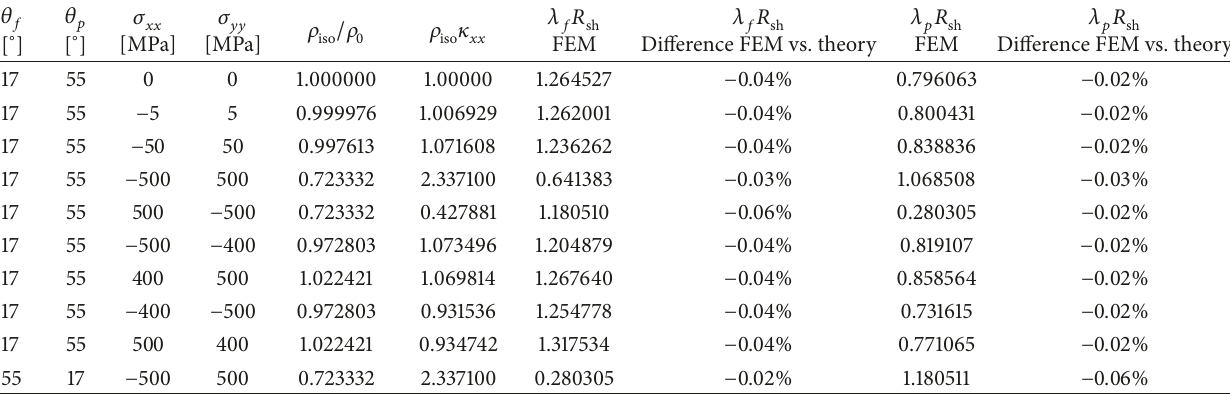
Table 2: Mechanical stress sensitivity of a circular device from Figure 10(a): comparison of numerical finite element simulation (FEM) versus analytical theory. 𝜆 𝑓 𝑅 sh is the resistance between the 𝜃 𝑓 -contacts in Figure 10(a) and 𝜆 𝑝 𝑅 sh is the resistance between the 𝜃 𝑝 -contacts in Figure 10(a). The mesh of the FEM-simulation had 2.66 million elements and the model used Lagrange multiplier and the piezoresistivity matrix from (6a) to (6c) with 𝜋 11 = 6.6 × 10 −11 / Pa, 𝜋 12 = −1.1 × 10 −11 / Pa, and 𝜋 44 = 138.1 × 10 −11 / Pa. The theory used (18d), (18e), (18g), (18h), (18i), (28b), (28c), and (26b) for 𝜌 iso 𝜅 𝑥𝑥 > 1 . For 𝜌 iso 𝜅 𝑥𝑥 < 1 we swapped 𝜃 𝑓 with 𝜃 𝑝 in (28b) and (28c) and 𝜆 𝑓 with 𝜆 𝑝 , and we replaced 𝜌 𝜅 → (𝜌 𝜅 ) −1 in iso 𝑥𝑥 iso 𝑥𝑥